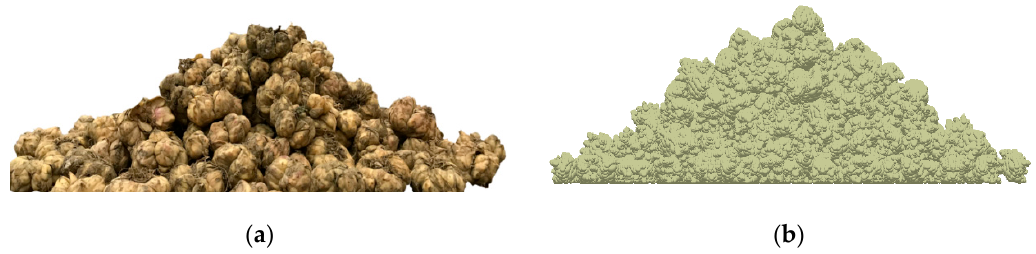
Figure 13. Comparison of physical test and simulation test. ( a ) Physical test; ( b ) Simulation test.